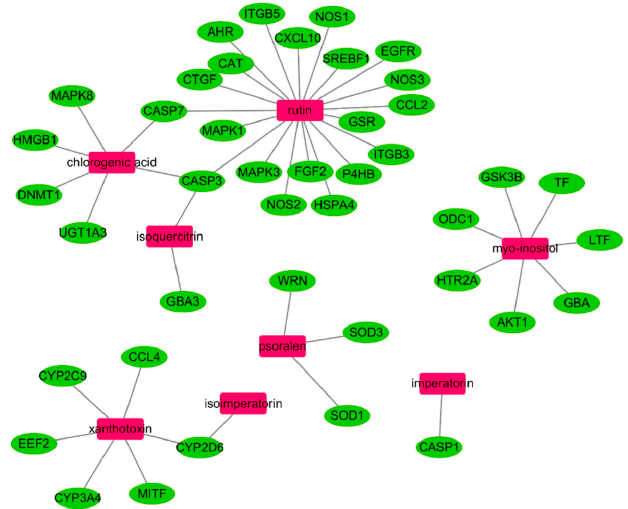
Figure 5. Compound-target gene network linking the protective effects of PJE against OA to potential target genes and signaling pathways. Compounds derived from PJE are indicated by pink rectangles, target genes are represented by green ovals, and gray lines represent compound-target gene interactions. PJE: Peucedanum japonicum extract; OA: Osteoarthritis Table 2. Kyoto Encyclopedia of Genes and Genomes (KEGG) pathways and target genes of